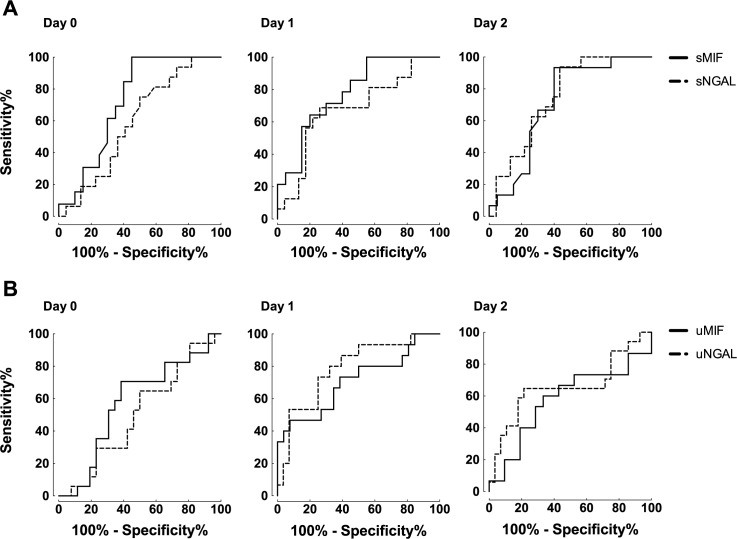
Receiver operating characteristic (ROC) curves of MIF and NGAL for predicting severe AKI after OLT.(A) ROC curves of serum MIF (sMIF, solid line) and serum NGAL (sNGAL, dashed line) at day 0, day 1 and day 2 after OLT. (B) ROC curves of urinary MIF (uMIF, solid line) and urinary NGAL (uNGAL, dashed line) at day 0, day 1 and day 2 after OLT.